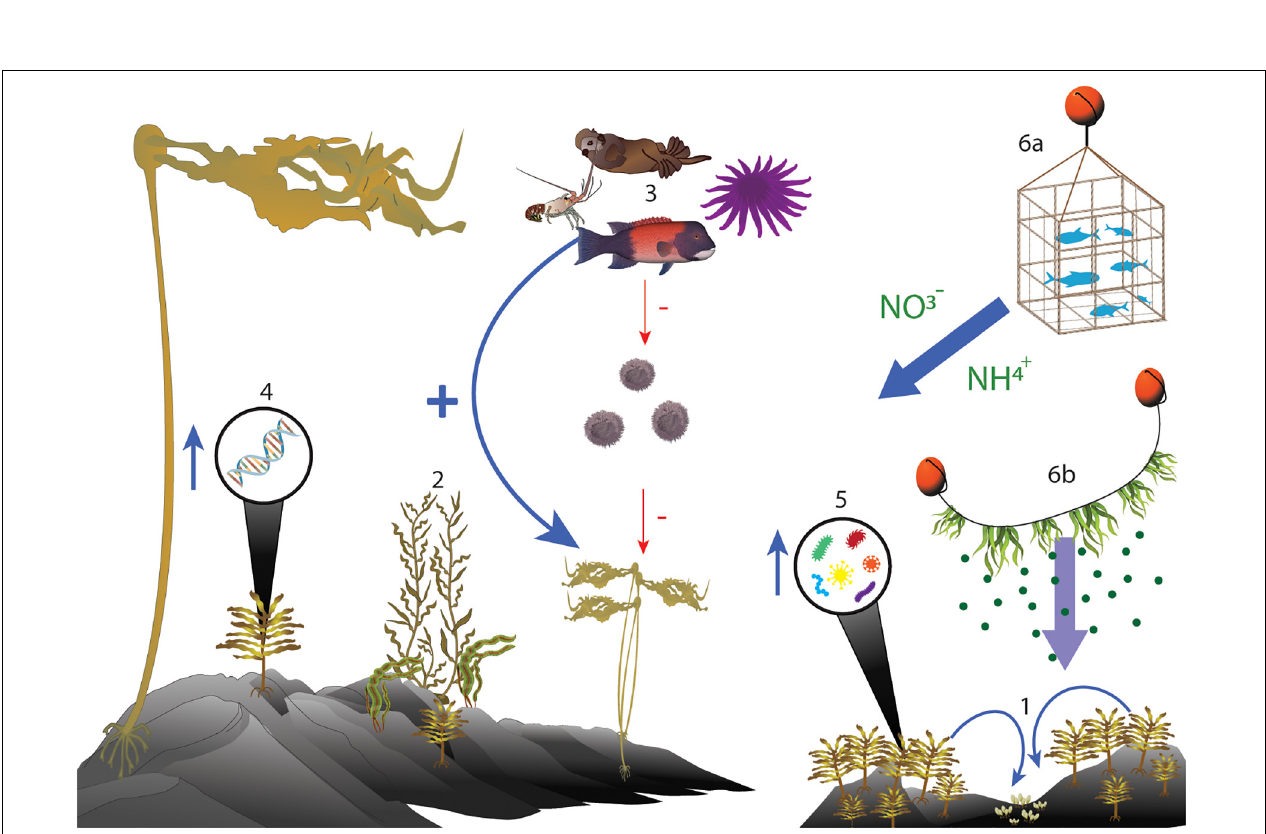
FIGURE 2 | Ecosystem diagram of different positive interactions that may be used in kelp forest restoration. 1: Intraspecific facilitation. 2: Interspecific foundation species facilitation. 3: Trophic cascades. 4: Genetic manipulation. 5: Manipulation of microbial communities. 6a: Fish farms and nutrient cycling. 6b: Kelp farms and spore